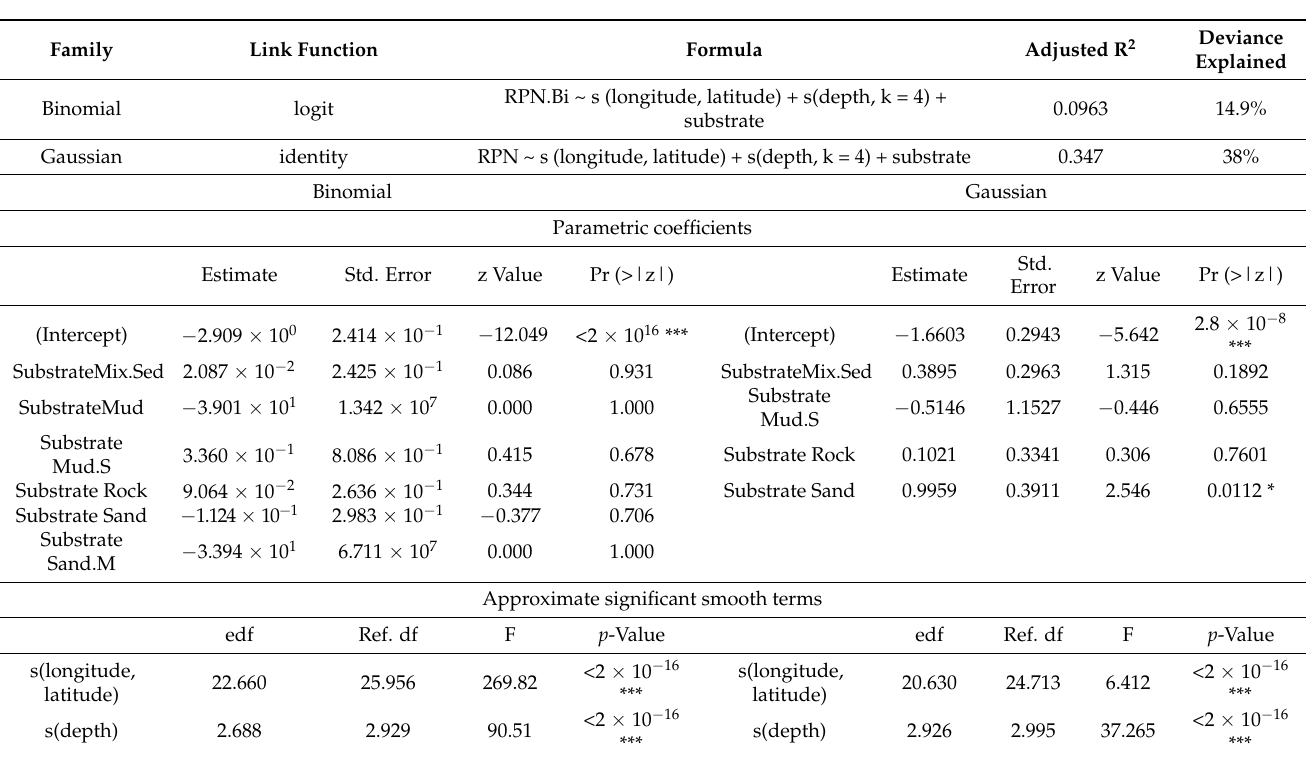
Table 1. Detailed summary table of generalized additive model (GAM) results for Lepidopus caudatus abundances and presence, derived from scientific surveys (1996–2019) in the Azores. Substrate type: coarse sediment (C. Sed), mixed sediment (Mix.Sed), mud (Mud), muddy sand (Mud.S), rock (Rock), sand (Sand), and sandy mud (Sand.M). The significative codes are: 0 ‘***’ 0.01 ‘*’ 0.05 ‘.’ 0.1 ‘ ’